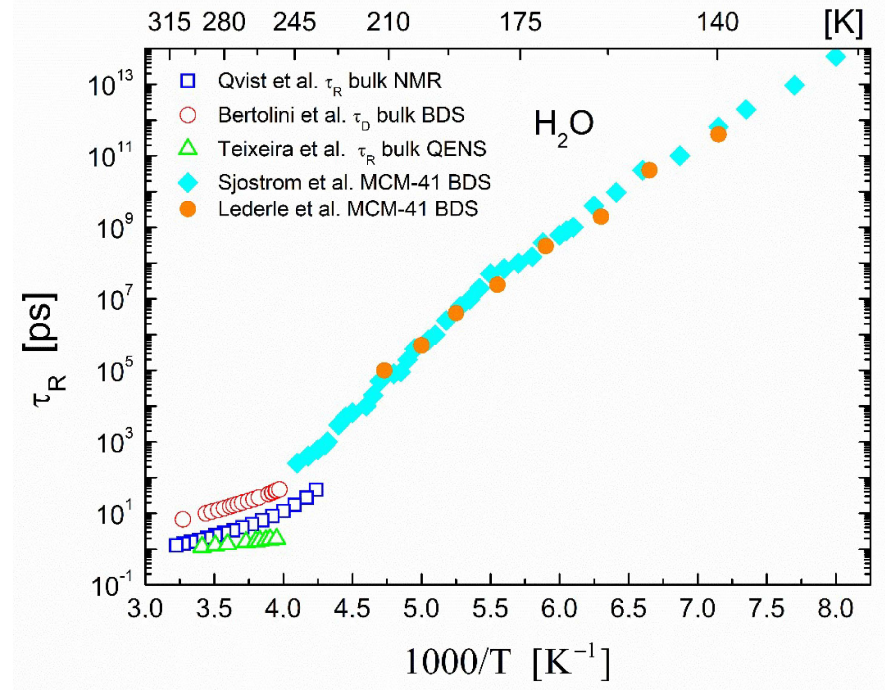
Figure 5. Temperature dependence of rotational correlation times τ R in bulk and confined water H 2 O. Open squares ( (cid:3) ) are the rotational correlation times τ R of bulk H 2 O obtained from 17 O NMR experiments (Qvist et al. [67]). Open circles ( ) are the corresponding τ D values reported from (cid:35) the dielectric measurements of Bertolini et al. [64]; open upright triangles ( (cid:52) ) are the τ R values in bulk H 2 O obtained from the QENS experiments of Teixeira et al. [61]. Filled diamonds ( (cid:7) ) are the correlation times τ R for supercooled H 2 O within MCM-41 pores with a diameter of around 2.1 nm obtained from the broadband dielectric spectroscopy (BDS) measurements of Sjöström et al. [94]. Filled circles ( • ) are the corresponding τ R values for supercooled H 2 O confined in MCM-41 pores with a 2.5 nm diameter reported by Lederle et al.